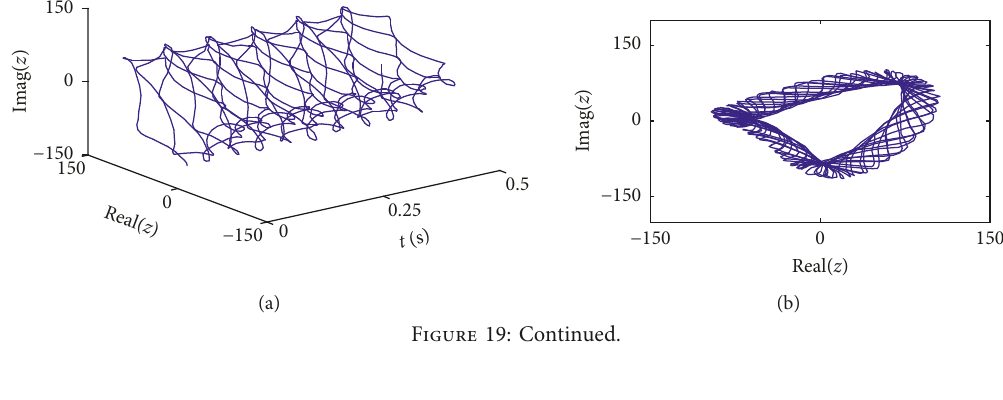
x 2 and a y 2 (a) and a x 3 and a y 3 (b) from the oil whirl signal.